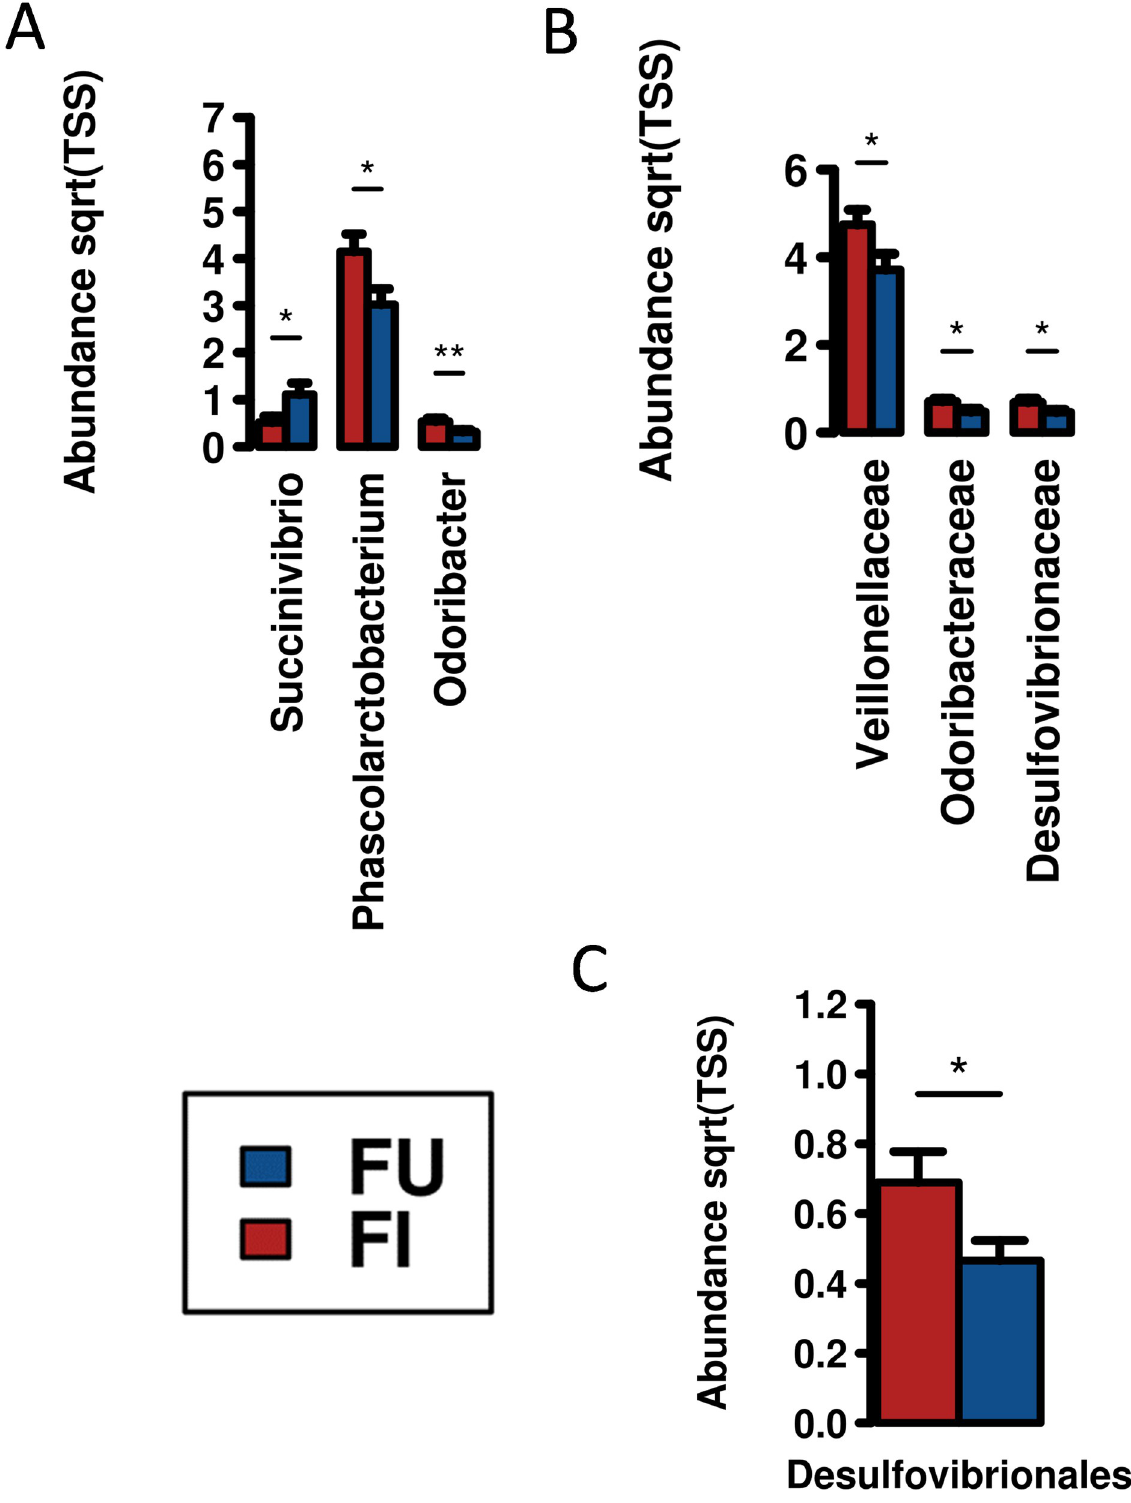
Fig 6. Univariate analysis of faecal samples from O . viverrini infected (red bars) individuals presented altered microbiota indicators compared to samples from uninfected (blue bars) individuals. Statistically significant A. genera, B. families and C. order are presented. � = p-value � 0.05; �� = p-value � 0.01. Complete lists of ANOVA are presented in S5 Table.